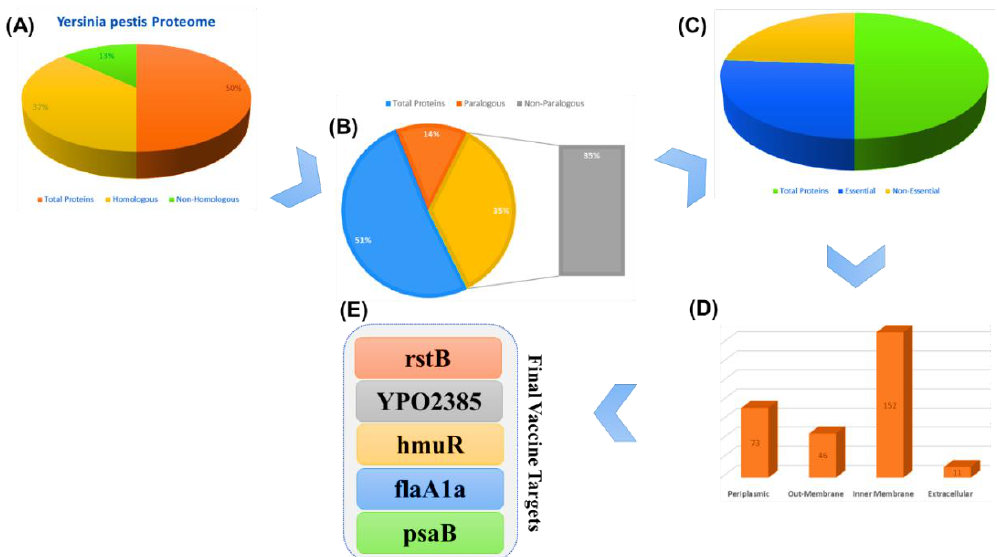
Figure 2. The steps of the subtractive proteomics, and the results obtained from each step. ( A ) represent the whole proteome of Y. pestis with the total number of proteins, homologous and non-homologous. ( B ) shows the whole proteome of Y. pestis with the total number of proteins, paralogous and non- paralogous. ( C ) whole proteome of Y. pestis with the total number of proteins, essential and non-essential. ( E ) final vaccine targets while ( D ) represent the cellular location of different proteins.